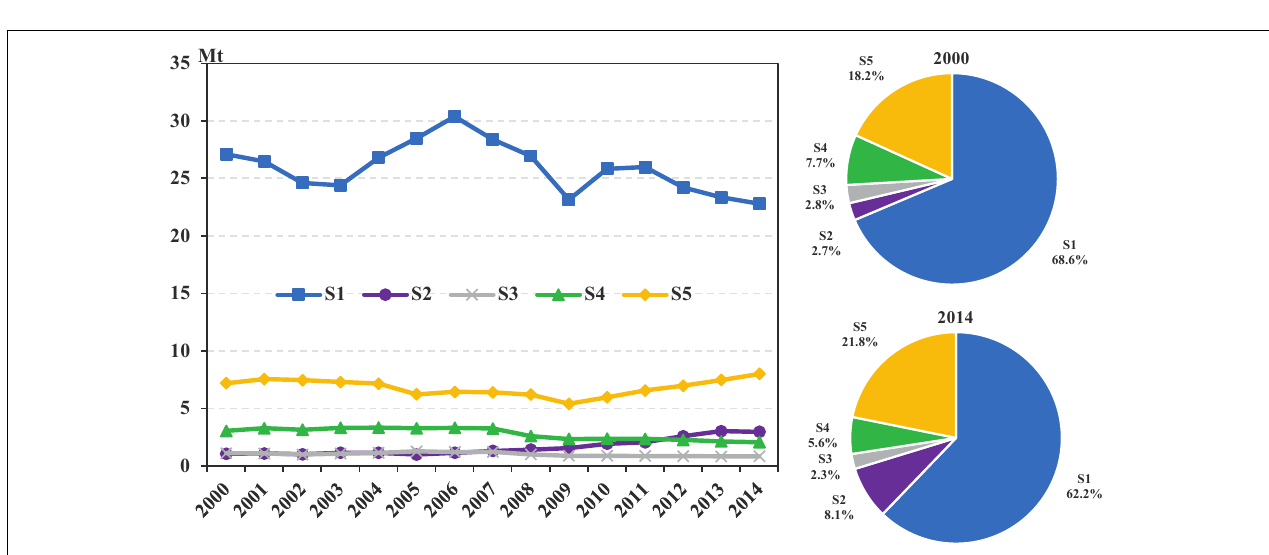
FIGURE 4 | The global embodied carbon emissions of each ICT sector and their proportions in 2000 and 2014.